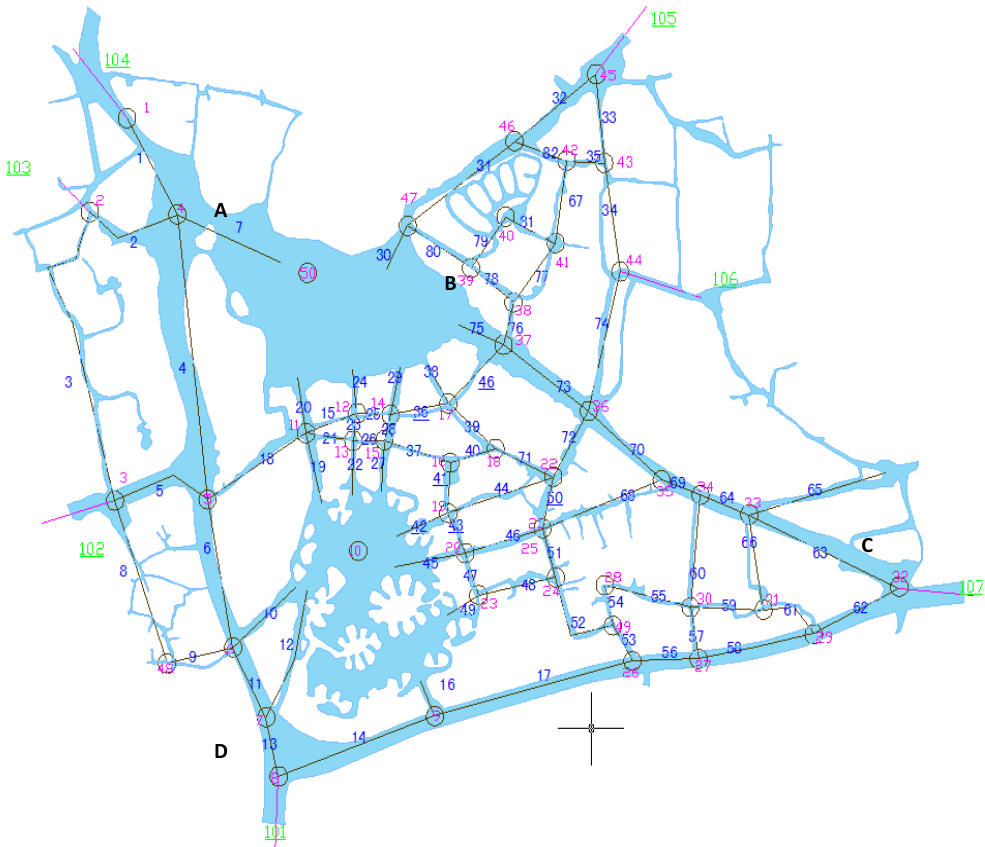
Figure 6. Simplification of inner river network in Phoenix